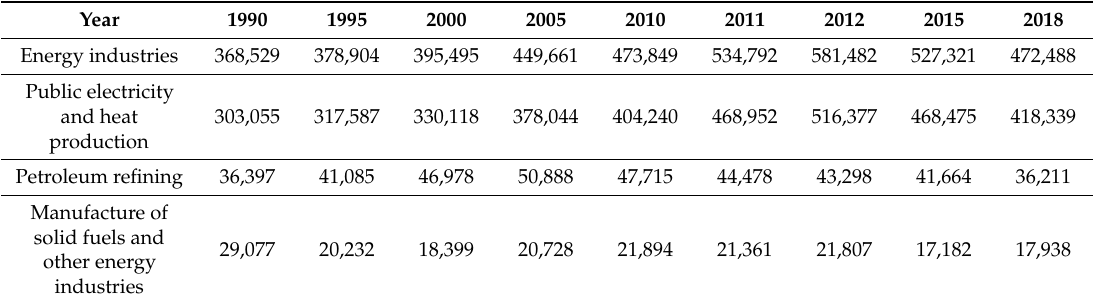
Table 1. Trends in CO 2 emissions in the energy sector (Thousand tones CO 2